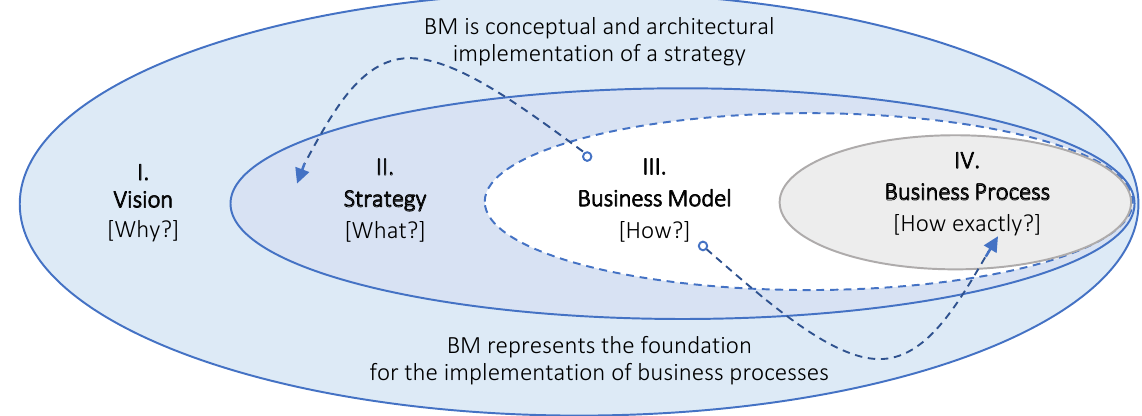
Figure 1. Relationship between business model, business process, company strategy, and company